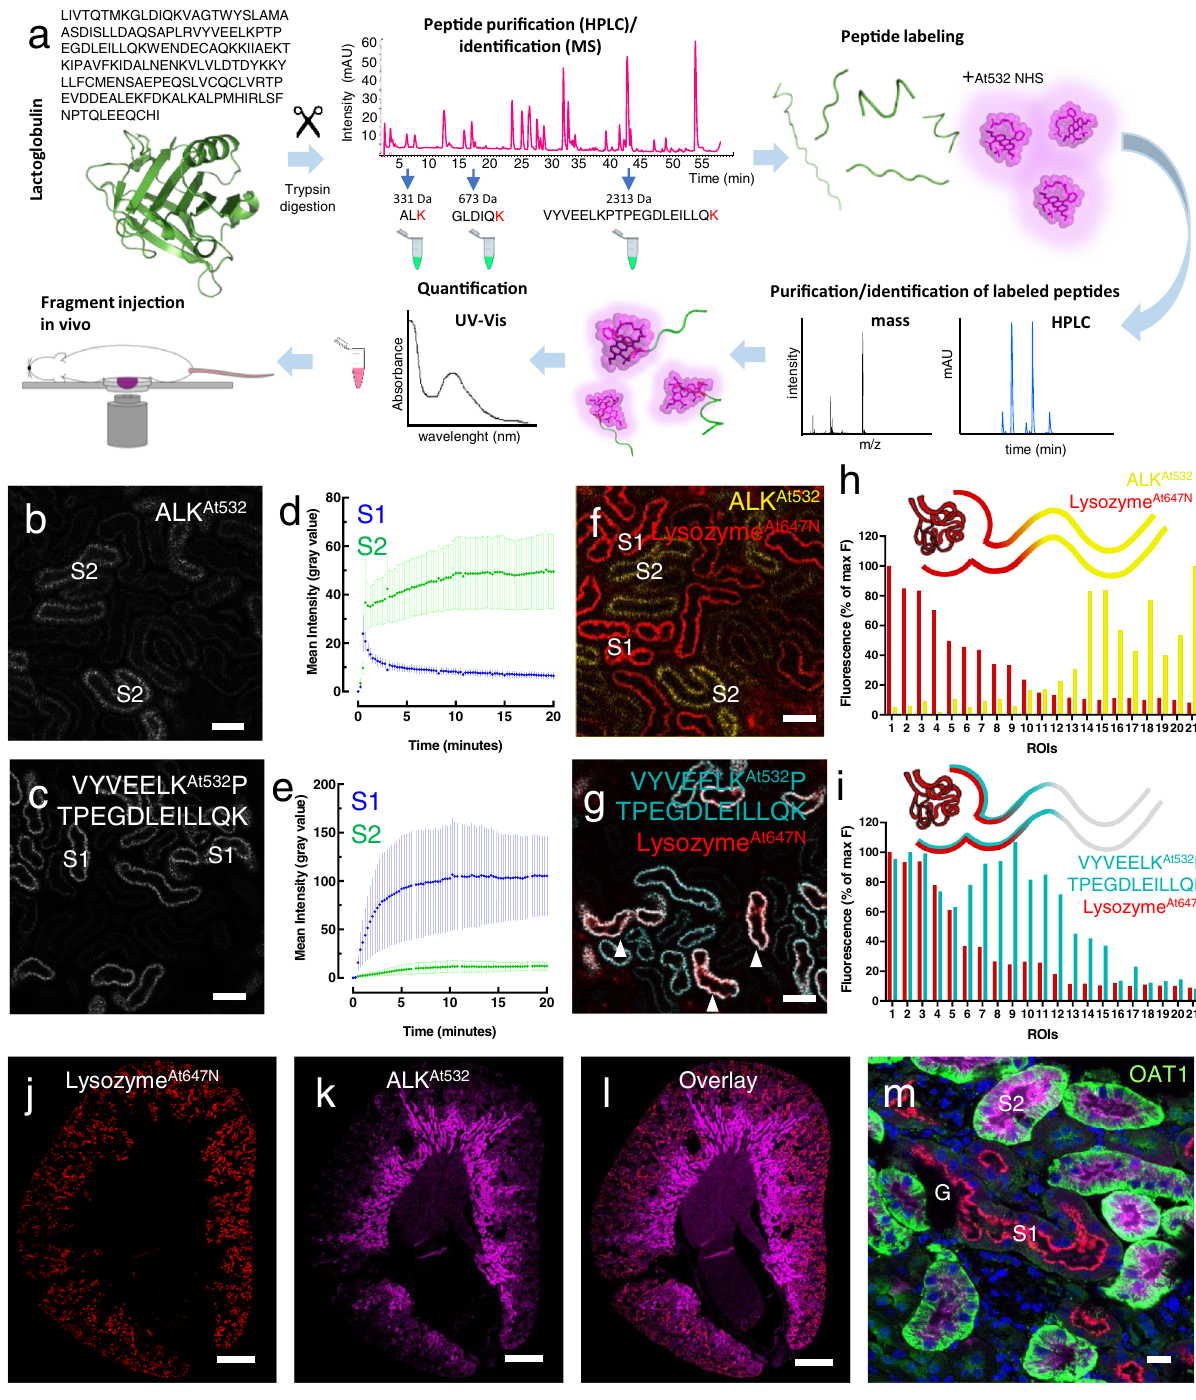
Fig. 2 | Small peptides bypass S1 and are reabsorbed in S2. a Enzymatically- digested lactoglobulin peptide fragments of different sizes were labeled with Atto 532 and puri fi ed, and their renal handling post intravenous injection was investi- gated with intravital imaging (mAU milli-absorbance unit). b The small peptide ALK At532 (331Da) was reabsorbed in S2 (representative of three independent experiments). Scale bar=20 μ m. c Conversely, a larger peptide VYVEELK- At532 PTPEGDLEILLQK (2313Da) triggered S1 uptake (representative of three inde- pendent experiments). Scale bars=20 μ m. d , e ROIs were drawn around tubular segments and the plots depict fl uorescence intensity over time post injection (mean value±SEM; n =3 mice per group). f , g Subsequent injection of intact lysozyme Atto647N showedaclearlydistinctuptakepatternfromthesmallpeptide,but not the larger species (representative of three independent experiments;